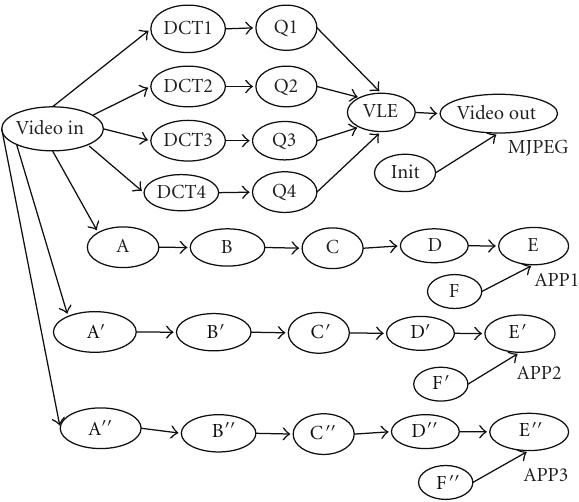
Figure 3: The Motion-JPEG (MJPEG) application model consid- ered for the case study. The MJPEG application is extended by injecting sporadic applications in each frame.